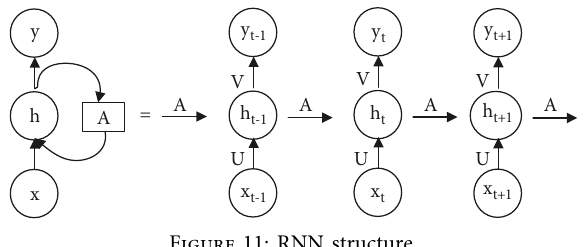
Figure 11: RNN structure.